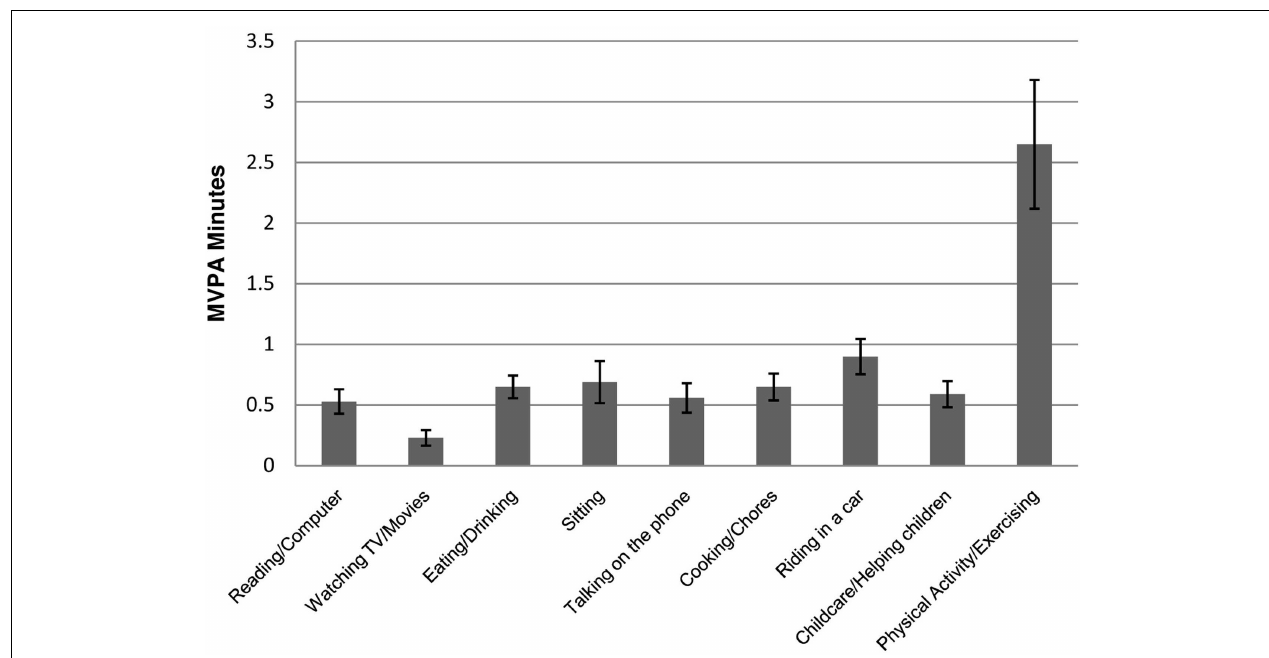
predicted marginal means generated through multilevel linear regressions, which adjusted for sex, age, race/ethnicity, annual household income, and weight status. Standard error (SE) bars are shown. Non-overlapping SE bars indicate a statistically significant difference between means at p < 0.05.